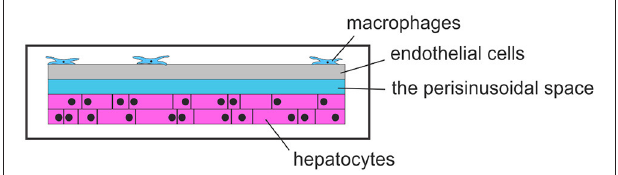
FIGURE 6 | Schematic view of